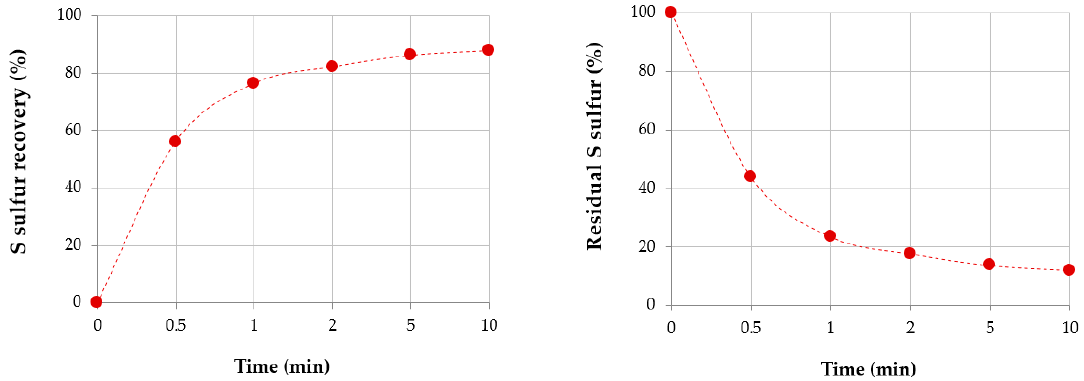
Figure 4. Flotation kinetic of the tailing: ( a ) % of S sulfide recovery vs. time; ( b ) residual % S sulfur vs. time.